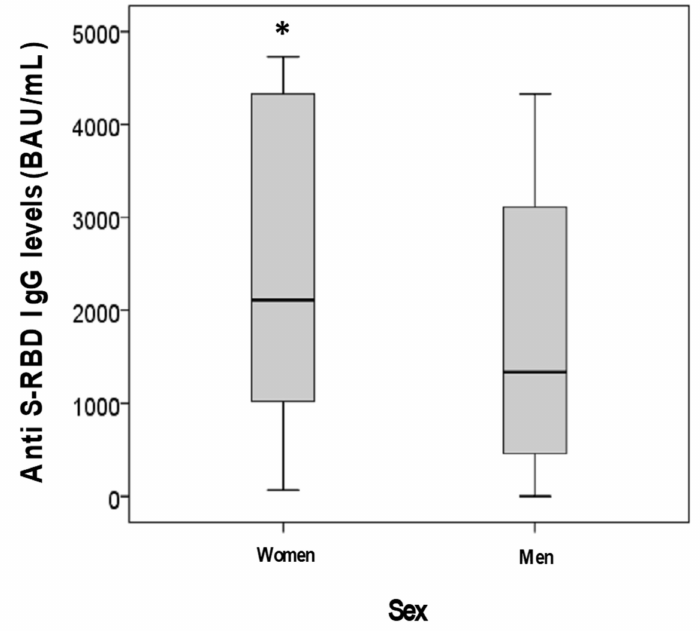
Figure 3. Anti S-RBD IgG levels in subjects sub-grouped according to sex (* p < 0.001 vs.